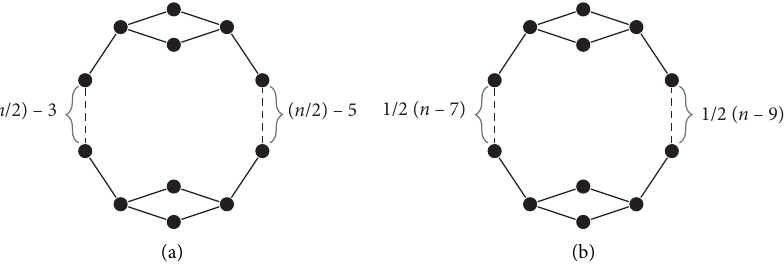
Figure 14: Tricyclic graphs with minimum edge Mostar index of order n , n ( ≥ 10 ) . (a) G